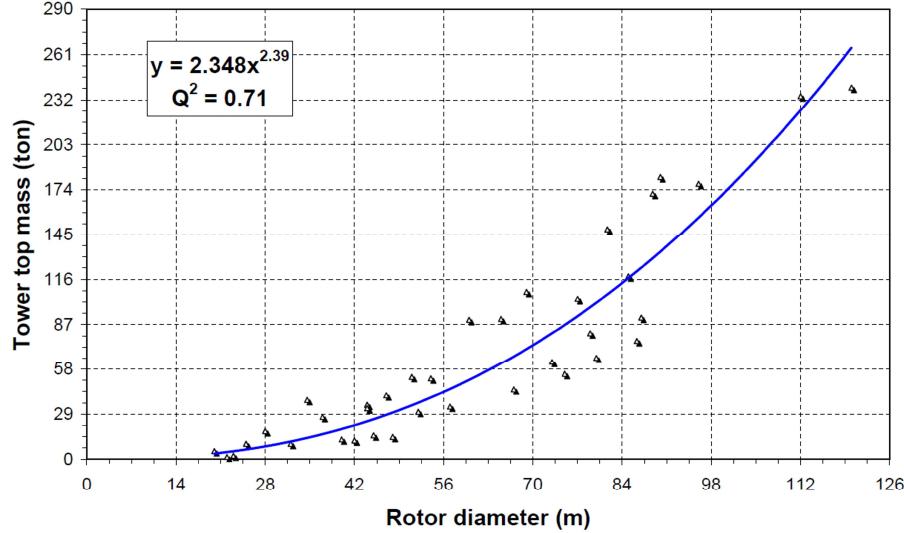
Figure 2. Tower Top Mass as a Function of Rotor Diameter, Commercial Data, and Trendline (reprinted from [14], reprint from [13]).